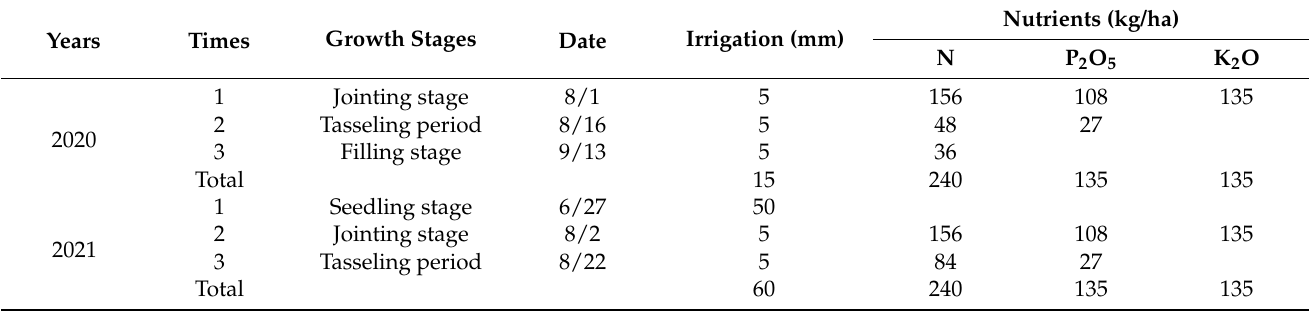
Table 1. Irrigation and fertilization schedules for 2020 and